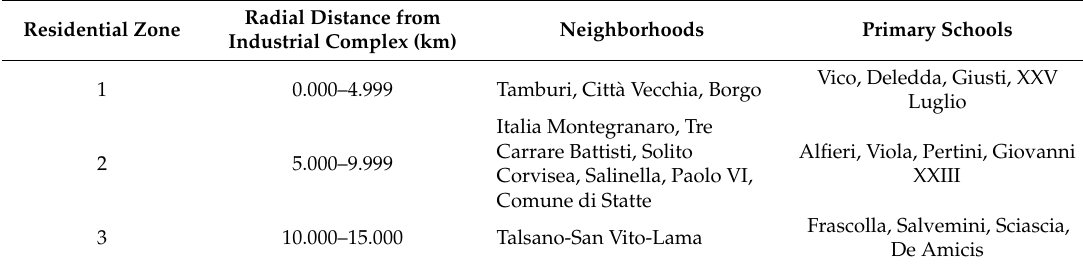
Table 1. Description of primary school enrollment sites by residential zone, distance from industrial complex, and neighborhood.